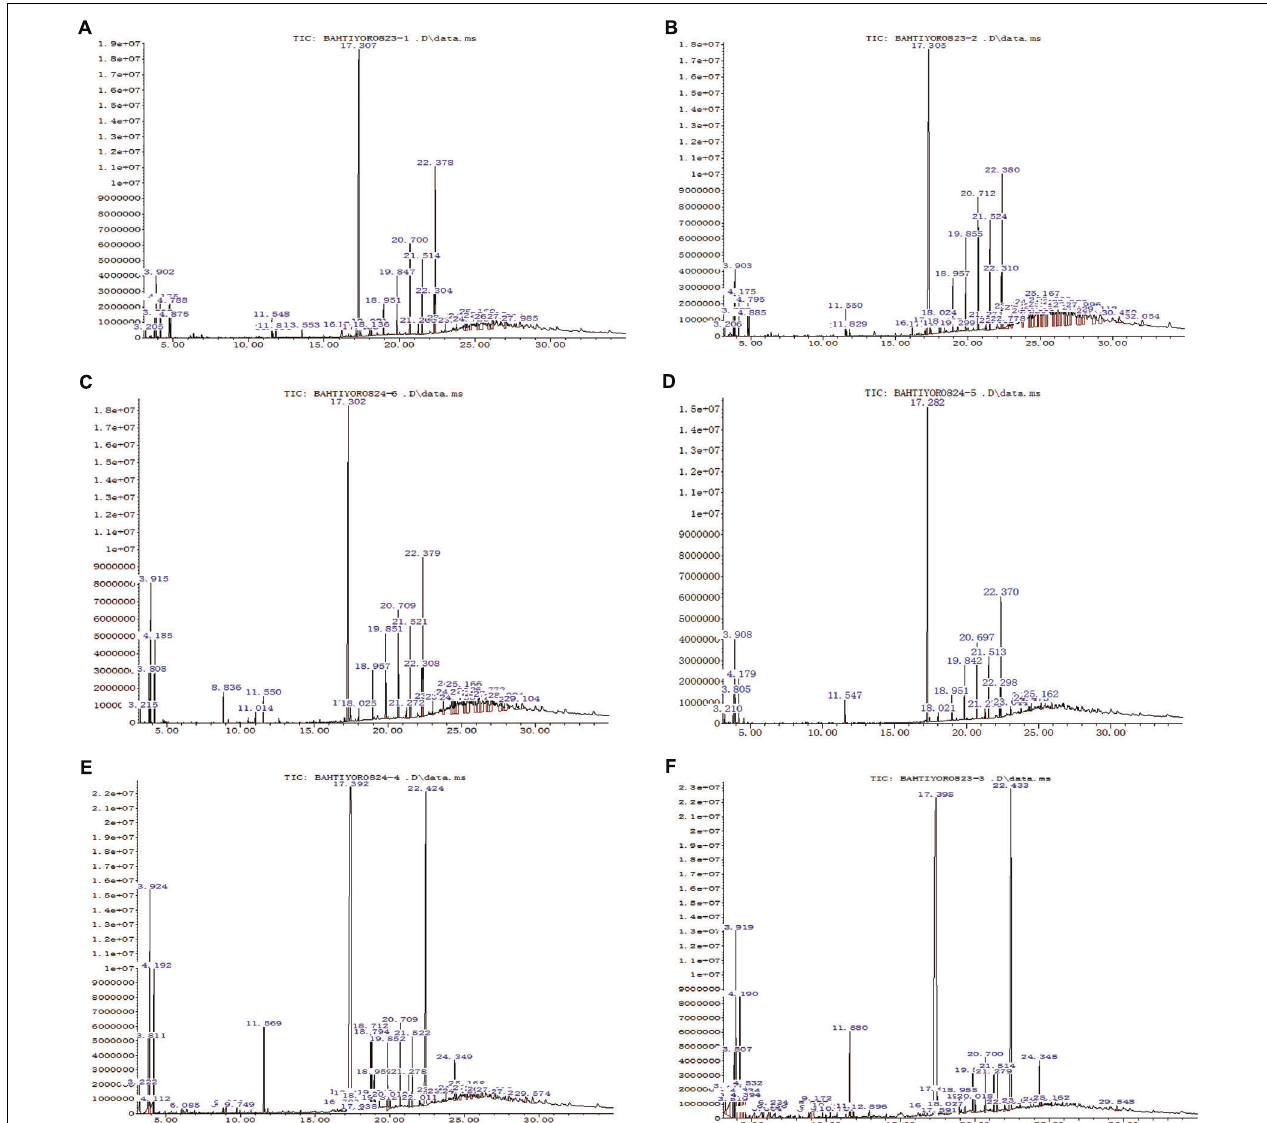
FIGURE 4 | GC-MS analysis of bioactive compound of ethyl acetate extract sample. (A) The crude extract of XEGI50 at pH 7; (B) The crude extract of XEGI50 at pH 3; (C) The crude extract of V. dahliae at pH 7; (D) The crude extract of V. dahliae at pH 3; (E) Antibiosis crude extract of XEGI50 and V. dahliae mixture at pH 7; (F) Antibiosis crude extract of XEGI50 and V. dahliae mixture at pH